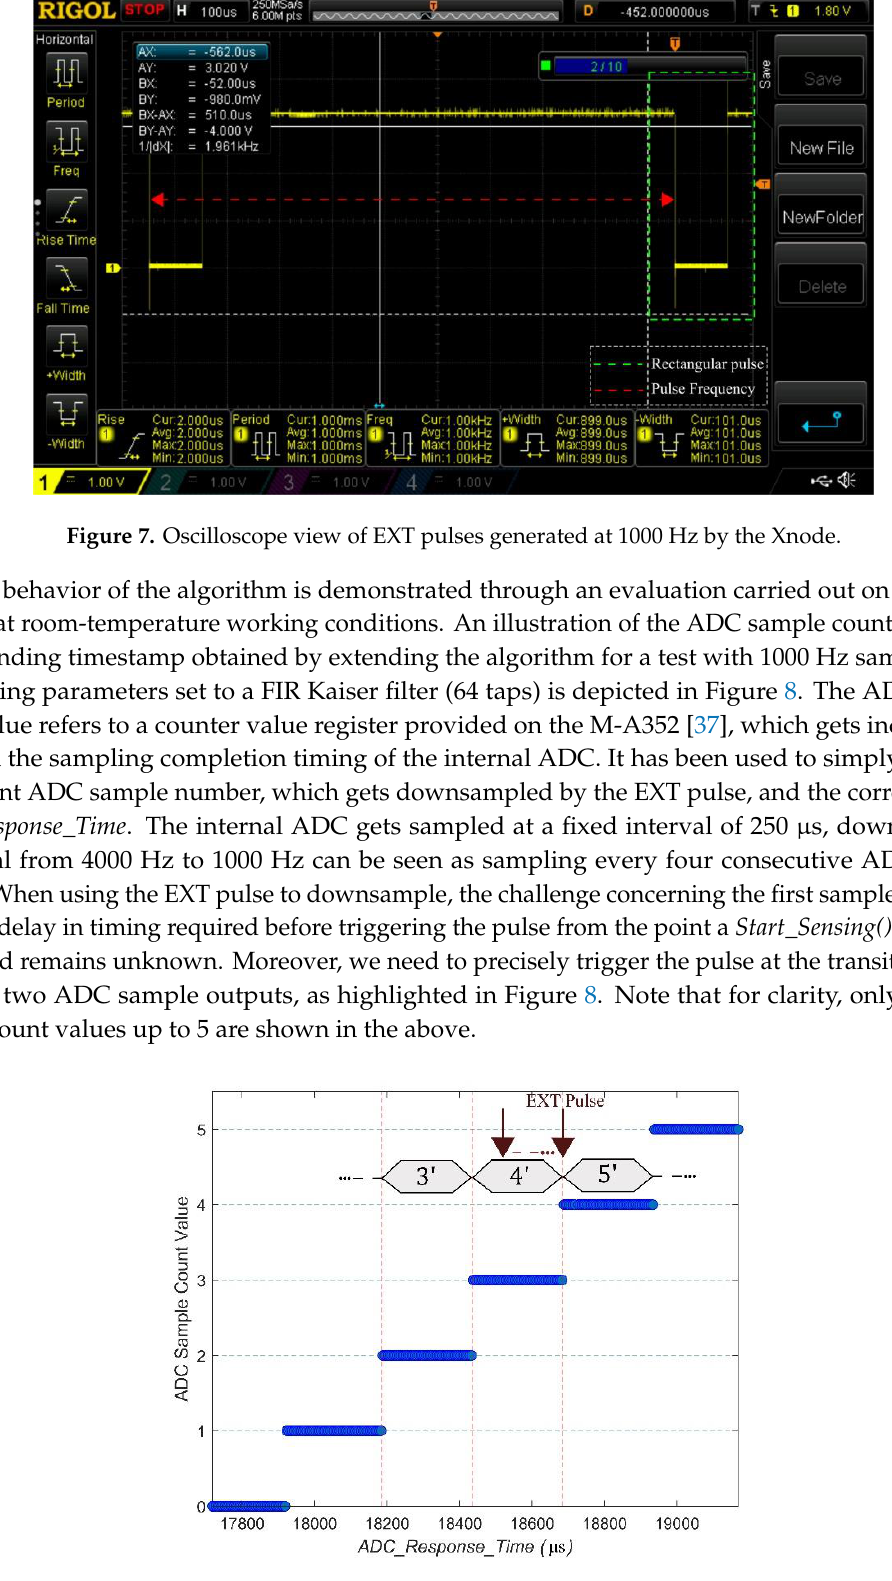
Figure 8. Timing diagram of ADC Startup delay evaluation with Epson M-A352.